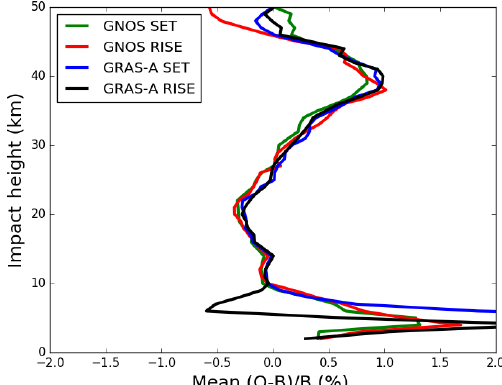
Figure 14. The L2 mean phase delay (m) versus the good and bad samples. Different colours represent different overlap densities, dark blue is the lowest and dark red is the highest, the colours be- tween them show gradually higher density.